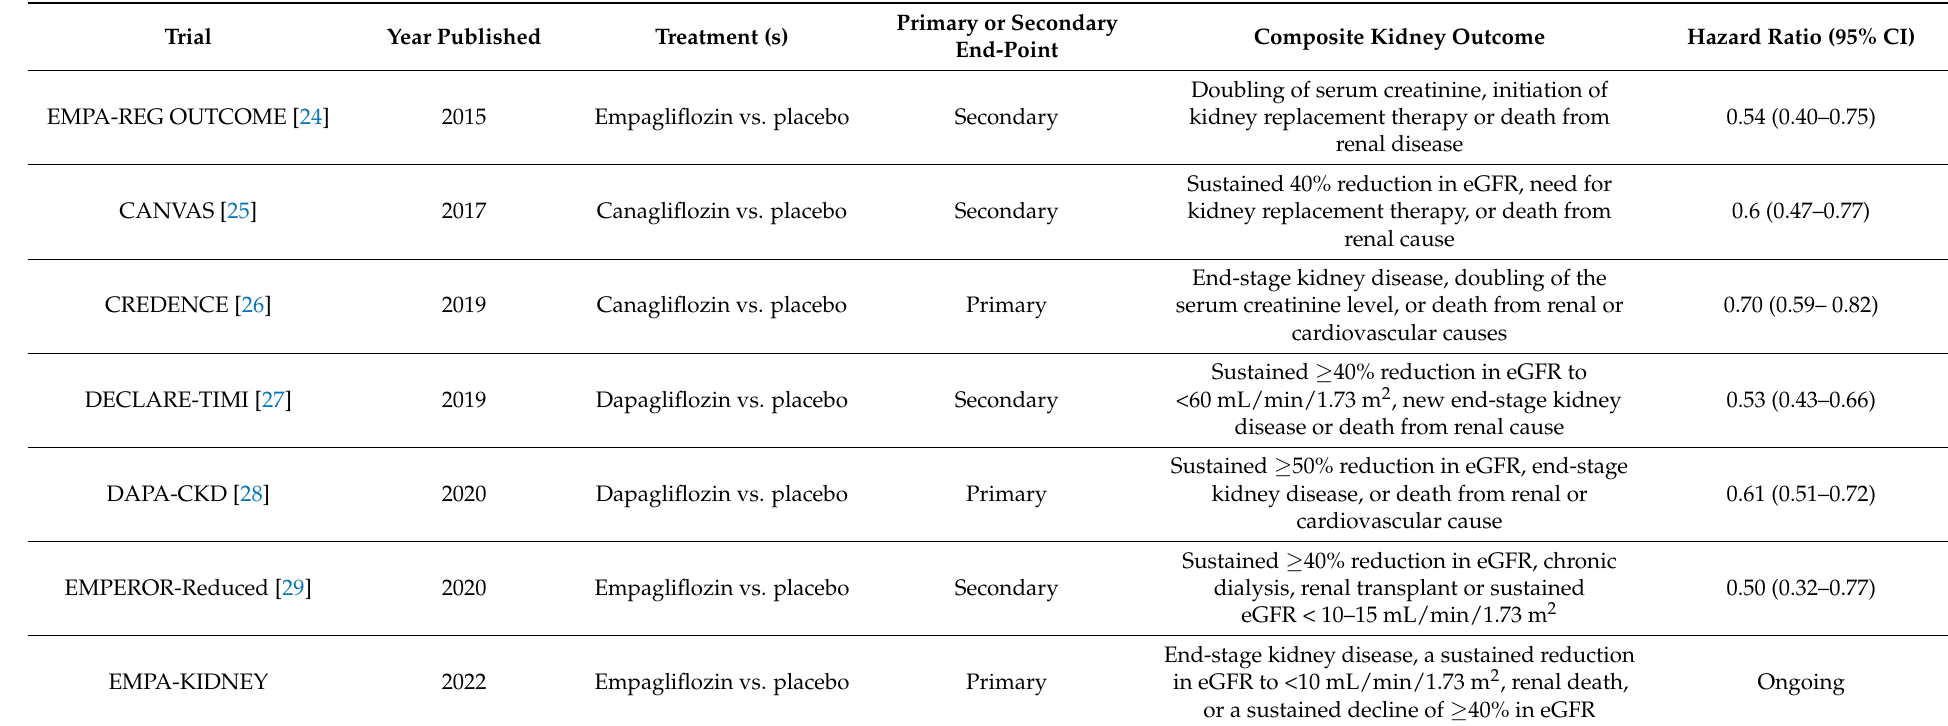
Table 2. Summaries of landmark trials with SGLT2